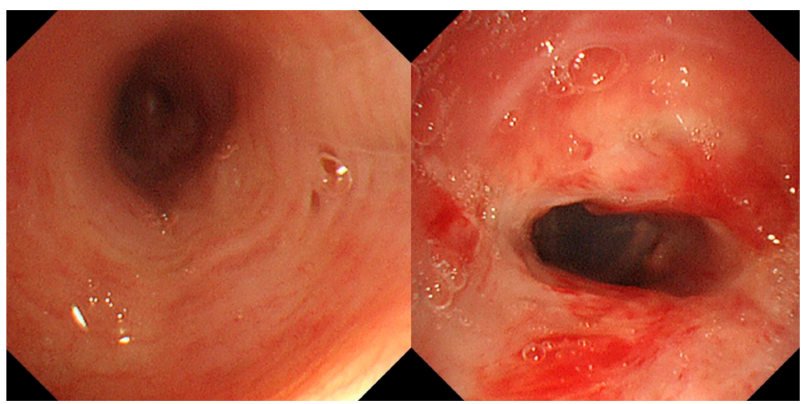
Figure 5. Follow-up bronchoscopic images. Improved multiple ulcerations with scars are noted in the proximal